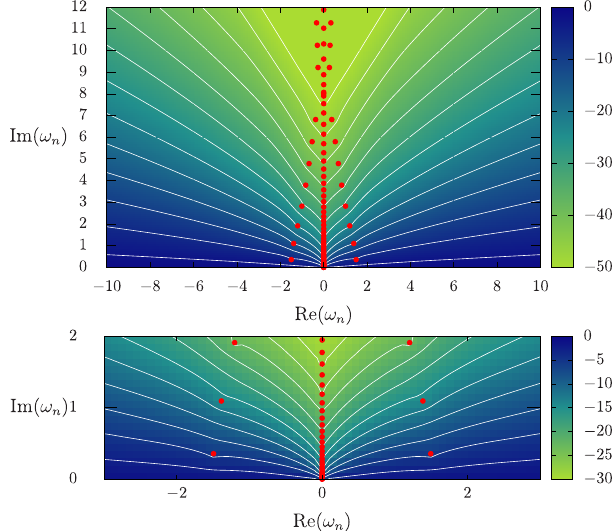
FIG. 13. Top panel: pseudospectrum of Schwarzschild space- time ( l ¼ 2 gravitational modes, from Regger-Wheeler potential, and similar for Zerilli). Again, QNM frequencies (red circles) from Fig. 12 are superimposed for reference on their (in)stability. The pattern of ϵ -pseudospectra sets σ ϵ is qualitatively similar to the Pöschl-Teller one (cf. Fig. 5), though presenting an enhanced spectral instability indicated by the smaller ϵ values of ϵ - pseudospectra contour lines (cf. range in color log scale for log 10 ϵ in Fig. 5). Bottom panel: zoom into the region around the fundamental QNM and first